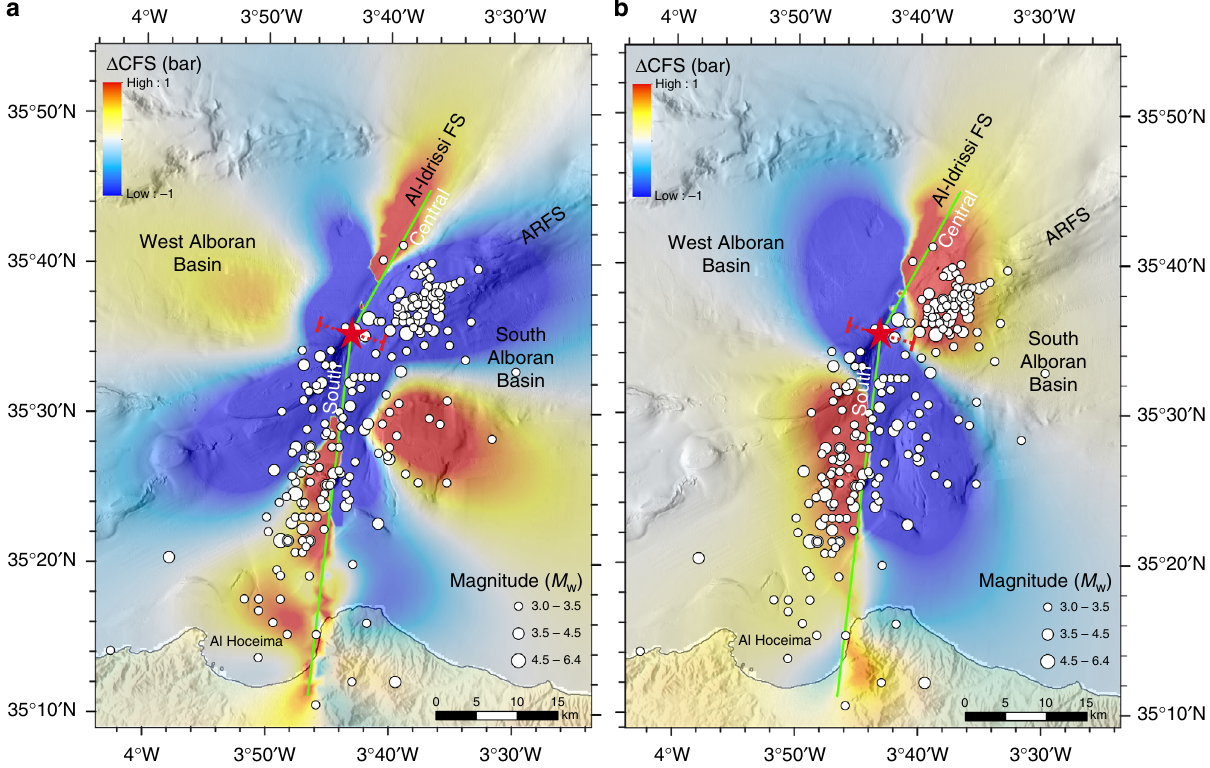
Fig. 6 Coulomb stress transfer modelling. a Calculated Coulomb failure stress change 41,42 ( Δ CFS) at 10km depth on receiver faults striking 210°, dipping 90° and with a rake of 5°. b Calculated Coulomb failure stress change ( Δ CFS) at 10km depth on receiver faults striking 070°, dipping 45° and with a rake of 85°. The source fault (light green line) mimics the coseismic slip determined from inversion of teleseismic waveforms (Supplementary Fig. 3), and corresponds to a vertical left-lateral strike-slip fault (rake 5°) that bends in the epicentral area. The South AIFS rupture strikes 007°N and extends for 45km, while the Central AIFS rupture strikes 031°N and extends for 20km. The boundary between the South and Central AIFS segments is depicted by a dashed red